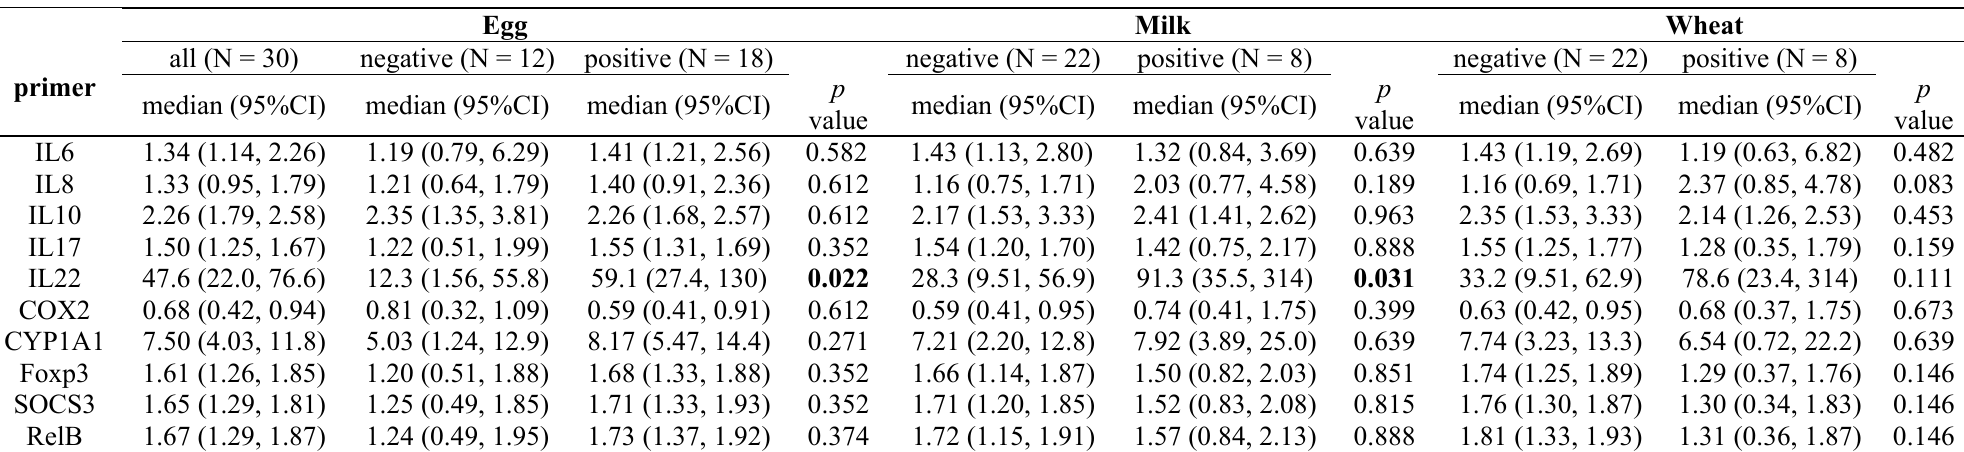
Table 2. Study on the influence of specific allergic status of all thirty children on the expression of several biomarkers as assessed by comparing children showing positive IgE reaction versus negative reactions, specifically to egg, milk or wheat.